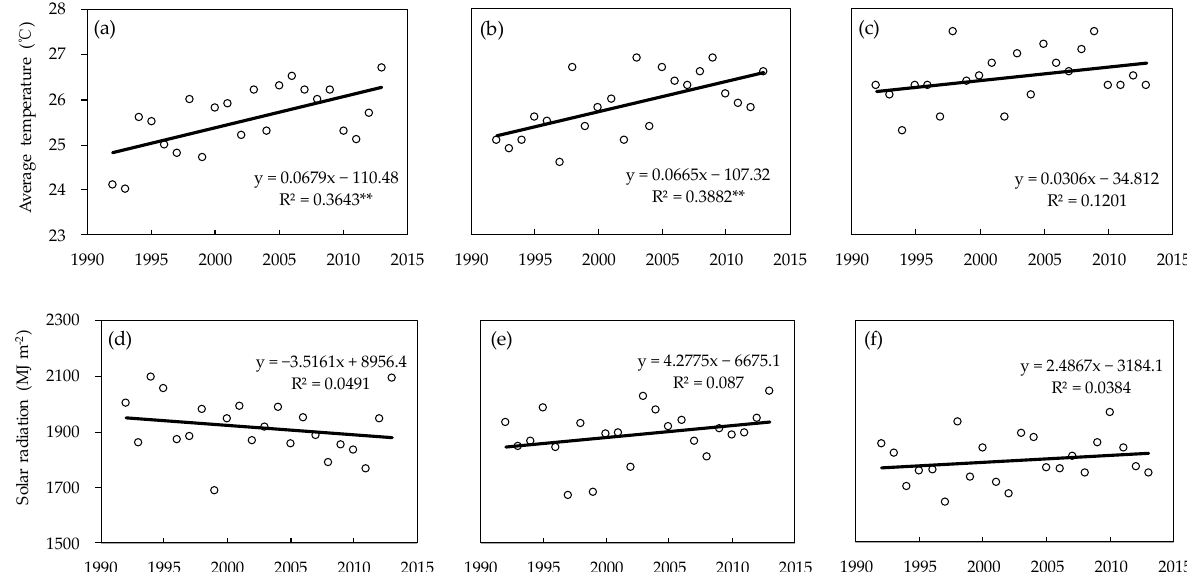
Figure 2. Trends in average temperature ( a – c ) and solar radiation ( d – f ) of the early rice growth period in the three climatic zones. ( a , d ), ( b , e ), and ( c , f ) indicate the northern subtropical zone (NST), middle subtropical zone (MST) and south sub- tropical zone (SST), respectively. * Significant at p < 0.05.